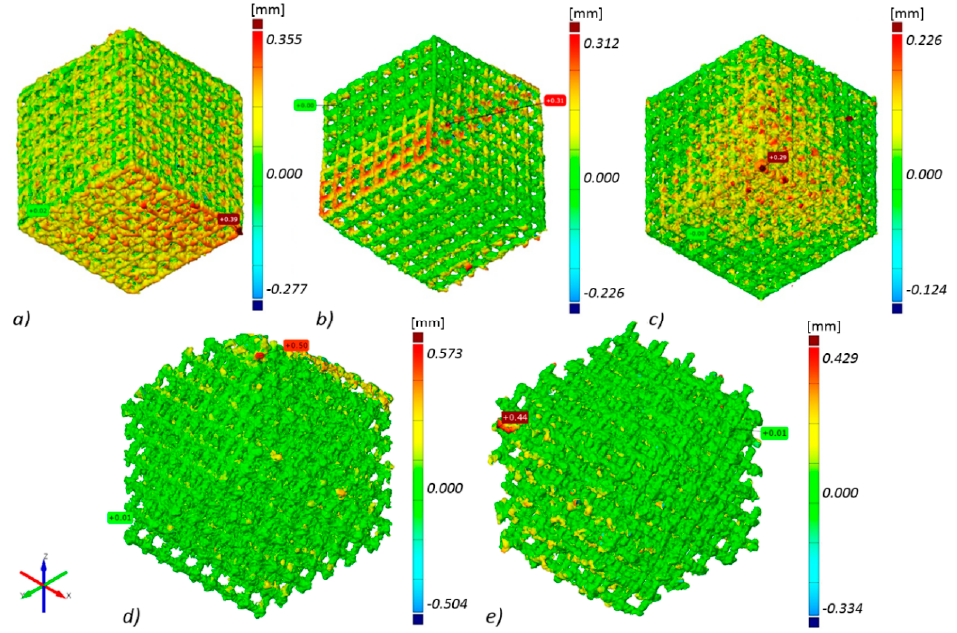
Figure 5. Geometry deviations of actual models from nominal model: ( a ) ‘A1 type’ specimen, ( b ) ‘A2 type’ specimen, ( c ) ‘A3 type’ specimen, ( d ) ‘B type’ specimen, ( e ) ‘C type’ specimen (the most appropriate scale was used for each sample so the geometric deviations were easy to analyze and